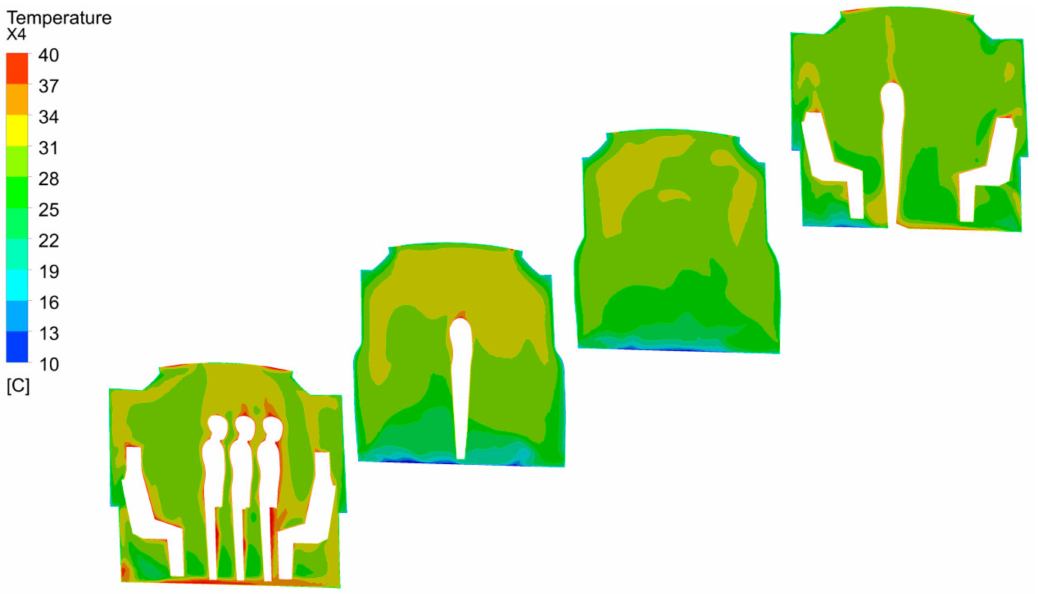
Figure 10. Temperature fields at vertical planes X1, X2, X3, and X4, winter case 7.